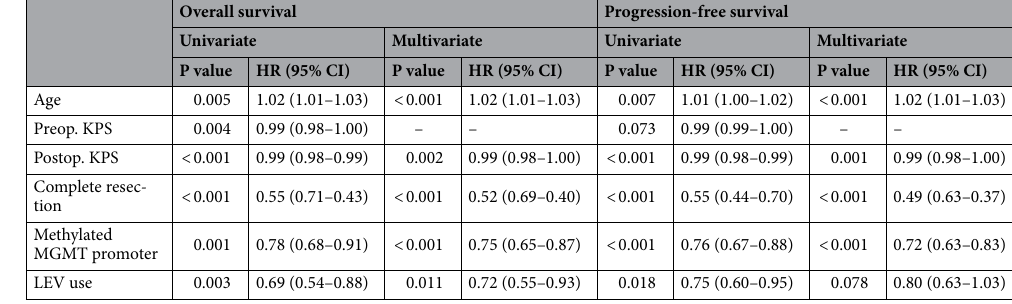
Table 3. Univariate and multivariate analyses of prognostic factors for overall survival and progression- free survival. HR hazard ratio, CI confidence interval, KPS Karnofsky Performance Status, MGMT O 6 - methylguanine-DNA methyltransferase, LEV